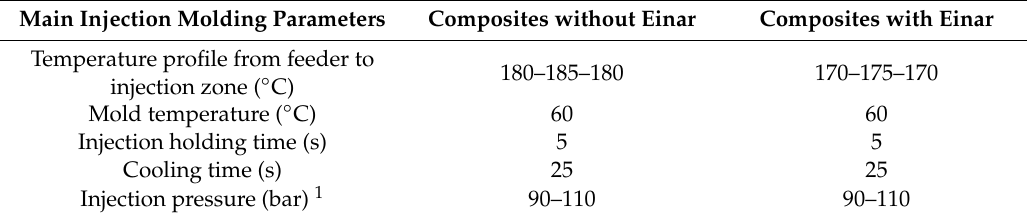
Table 2. Injection molding